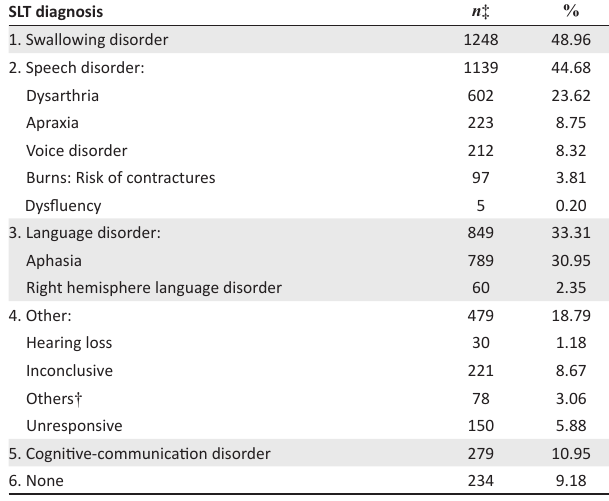
TABLE 1: Burden of disease profile ( n =